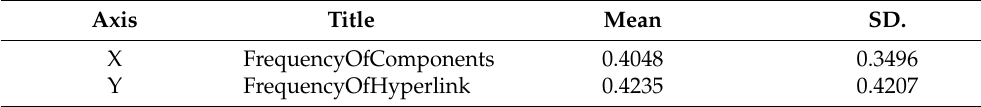
Table 2. Means and standard deviations of the coordinate axis.